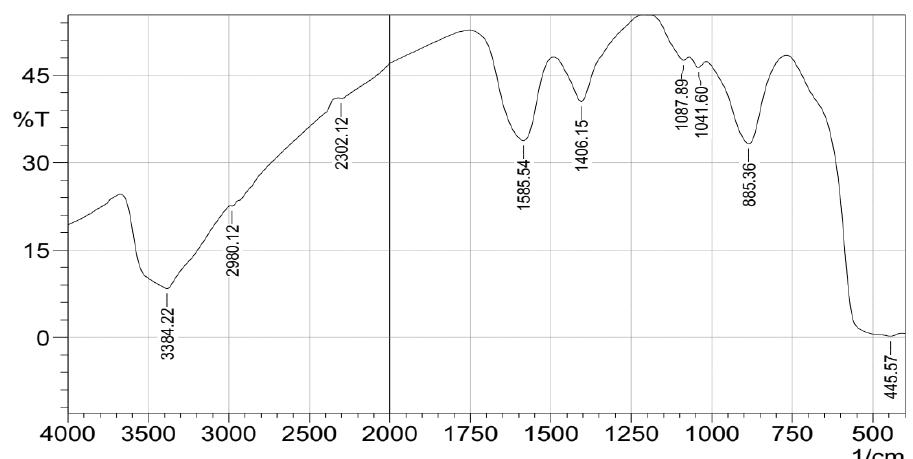
Figure 3. FT-IR spectra of Er-ZnONPs.